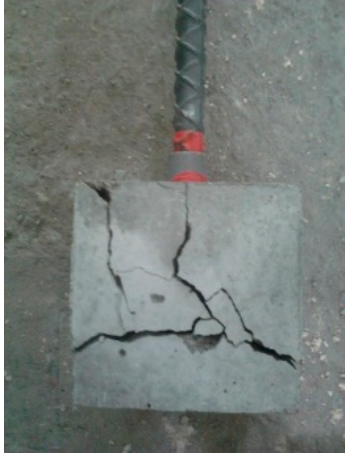
Figure 10. Appearance of the specimen with splitting failure.